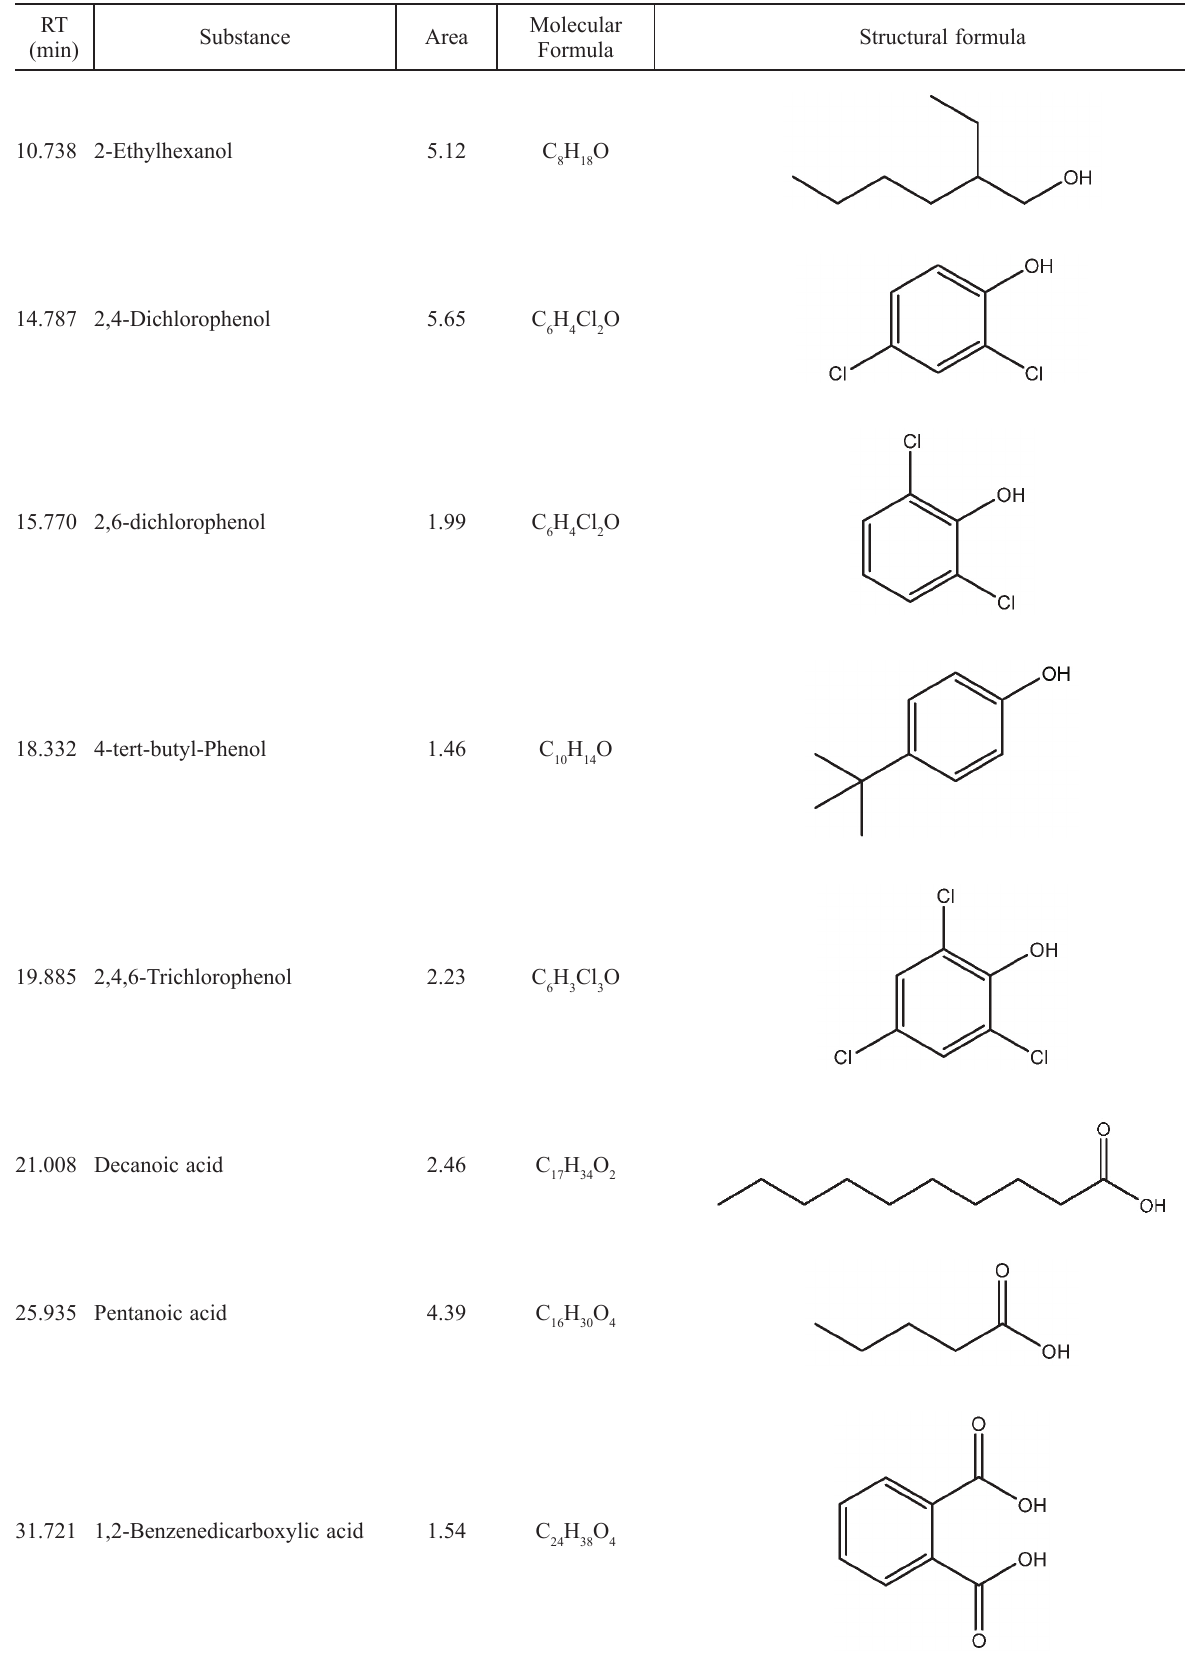
Table 3 – Gc-MS chromatogram of treated saline petrochemical wastewater by Pcc process on produced intermediates (Initial coD: 710 mg l –1 , voltage: 1.5 V, pH: 4, electrode distance: 2 cm, reaction time: 4 h) RT (min)